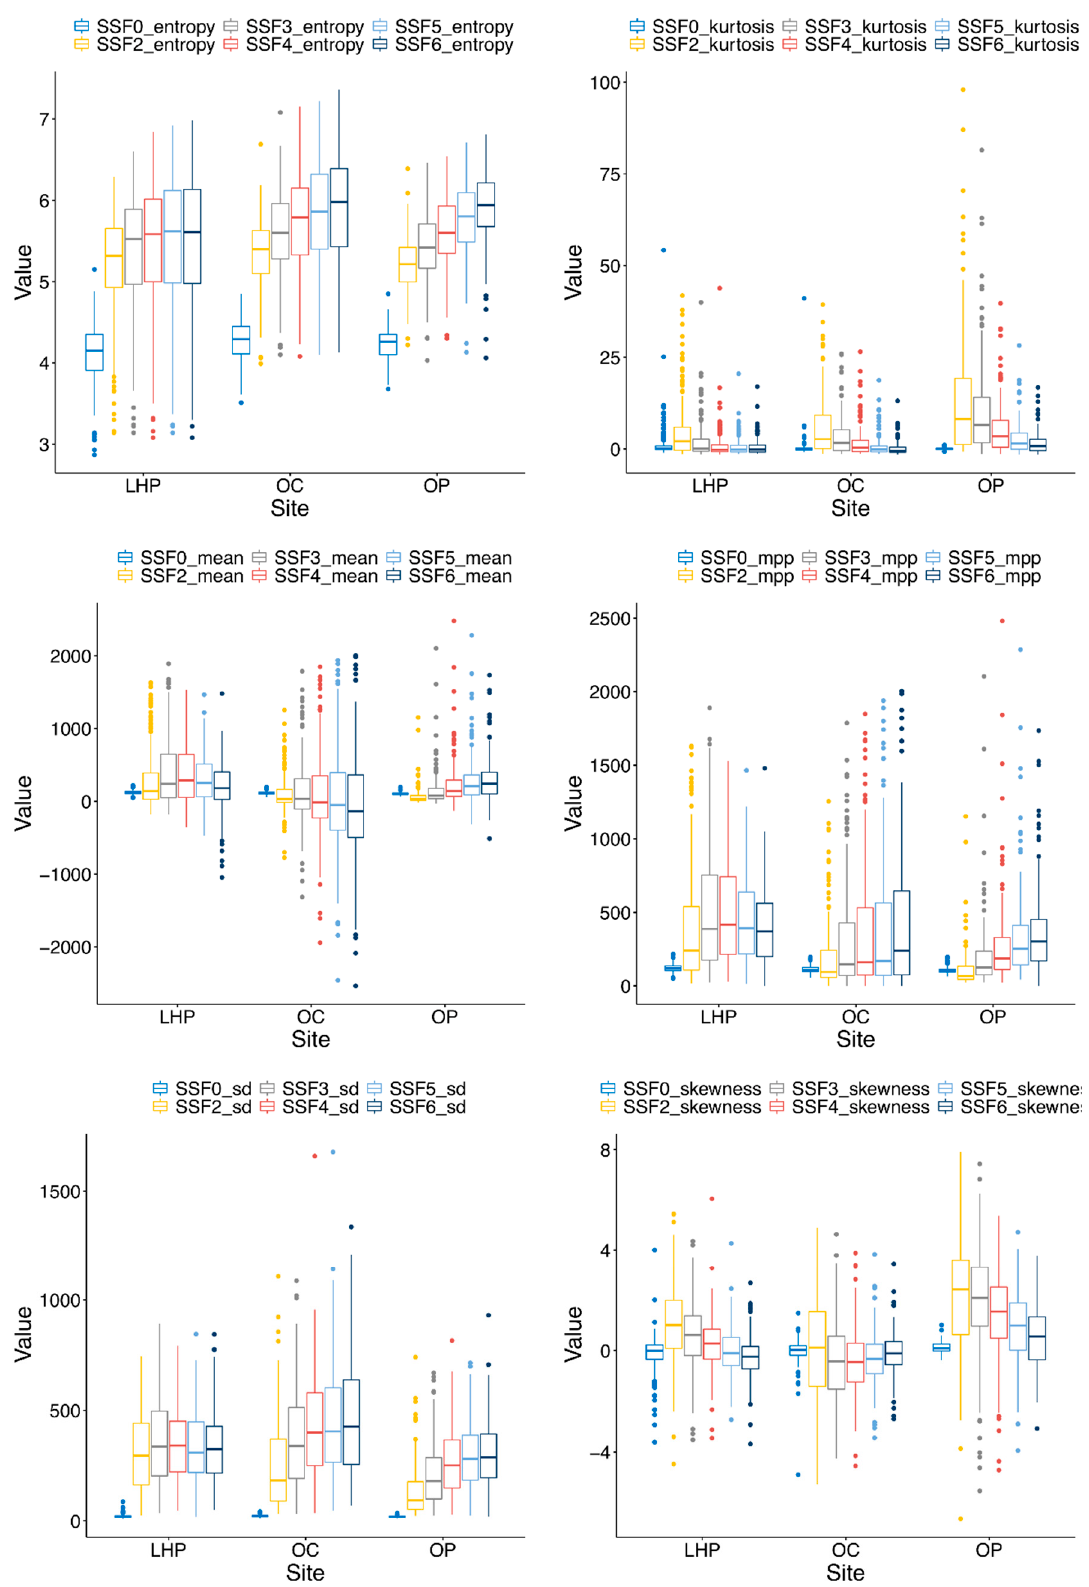
Figure 3. Box plots illustrating the distributions of quantitative features based on a gray-level intensity histogram including the mean, standard deviation, mean of positive pixels, entropy, skewness, and kurtosis. Each box plot represents the distributions of one feature for a different spatial scale filter (SSF 0, 2, 3, 4, 5, 6). LHP: larynx or hypopharynx; OC: oral cavity); OP: oropharynx.